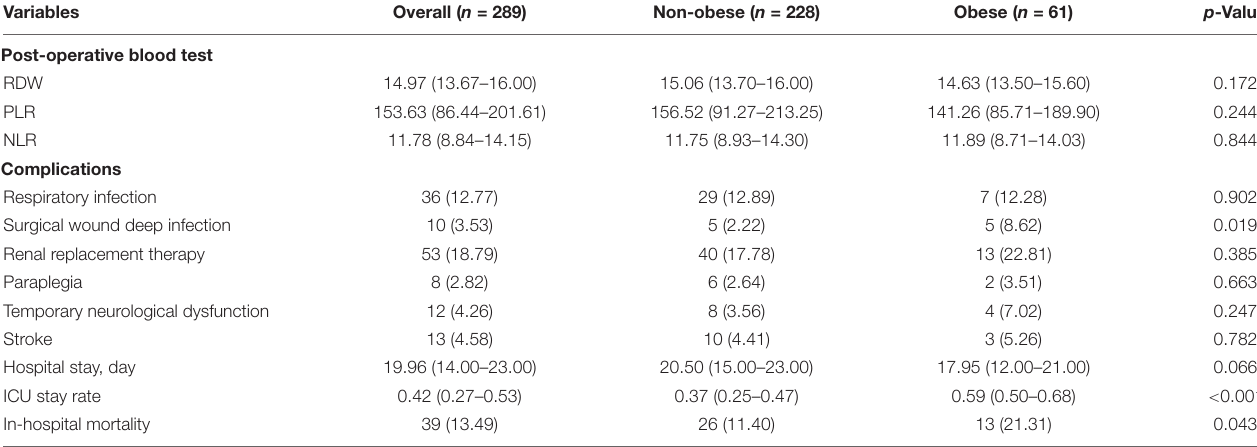
TABLE 4 | Post-operative